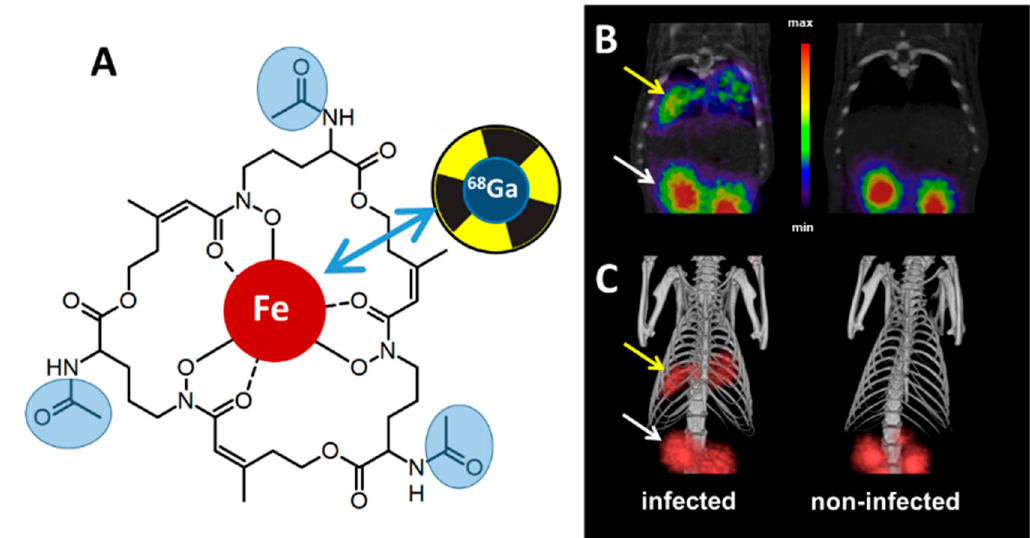
Figure 1. ( A ) Triacetylfusarinine C (TAFC) is shown in the ferri-form; the three acetyl groups lacking in FsC, which can be substituted by other residues for functional modifications, are shown in light blue. For TAFC-based nuclear imaging, the iron (shaded in red) is replaced by gallium-68 (blue double arrow). ( B ) µPET/CT coronal slices and ( C ) volume rendered 3D images of A. fumigatus in a rat infection model (thoracic part) after the intravenous injection of [ 68 Ga]Ga-TAFC showing clear accumulation (yellow arrows) in infected lung tissue ( left ). Accumulation in kidneys (white arrows) is caused by renal excretion of [ 68 Ga]Ga-TAFC; right: control, non-infected rat. CT: computed tomography, PET: positron emission tomography.